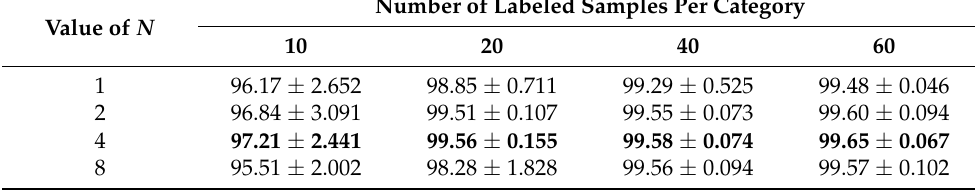
Table 5. Recognition accuracies of the proposed semi-supervised learning method for different N values under different amounts of labeled samples per category on the MSTAR data set. The bold numbers represent the optimal value in each